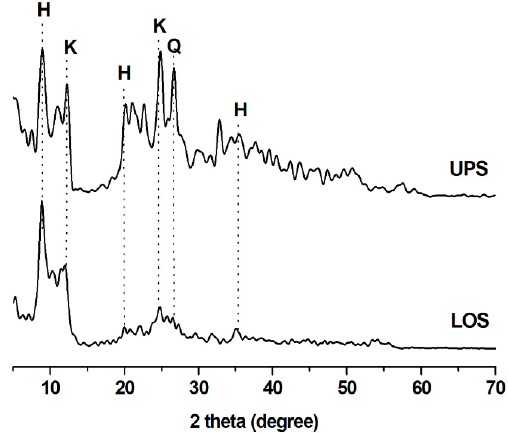
Figure 2. XRD results of the UPS and LOS samples. H—halloysite; K—kaolinite; Q—quartz.